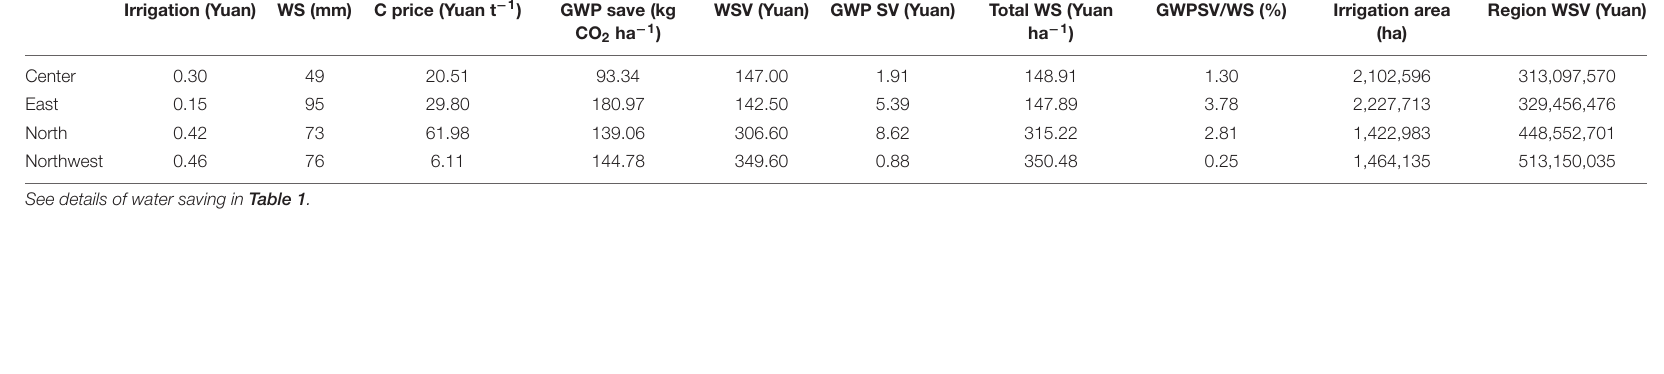
TABLE 5 | Estimated mean water saving (WS) or water saving value (WSV) and corresponding economic benefits in a specific region (for details, see Figure 1 ).